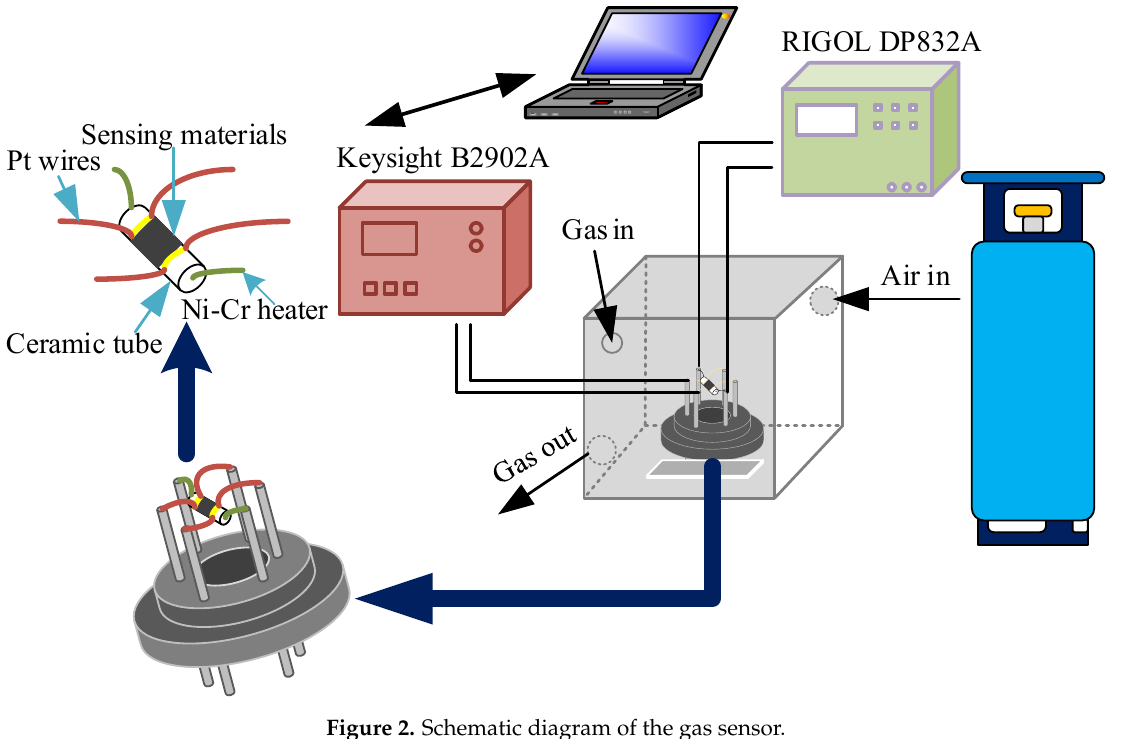
Figure 2. Schematic diagram of the gas sensor.